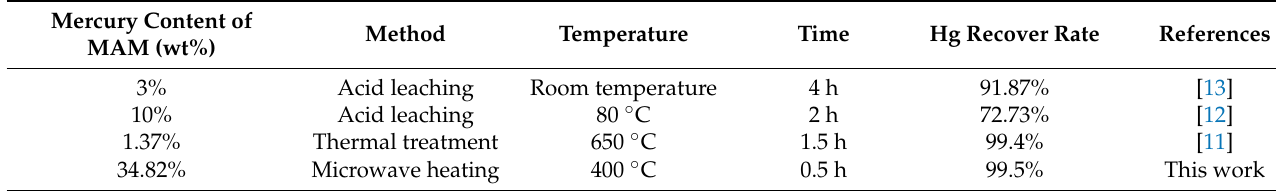
Table 2. Effect of different treatment methods on mercury recovery of